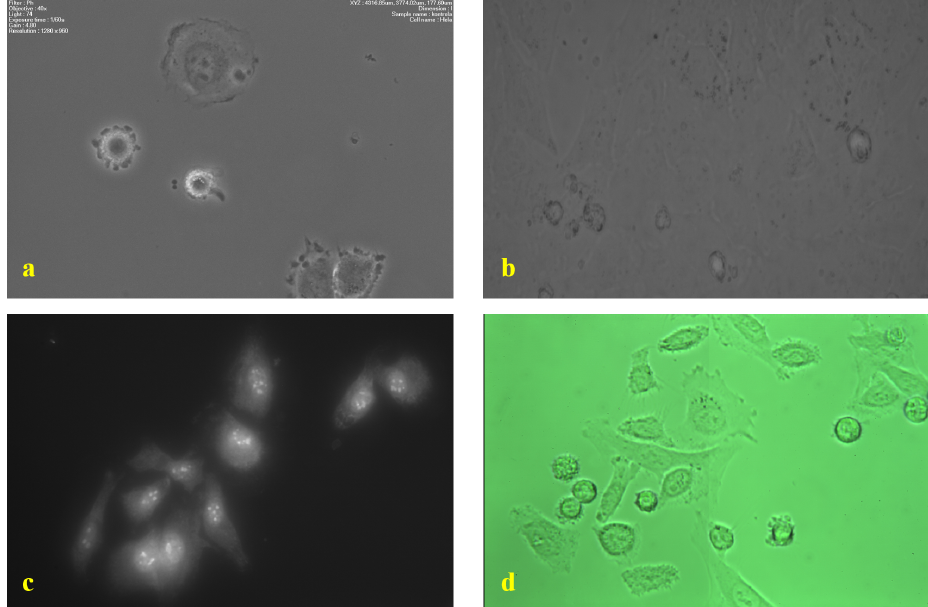
Figure 7. Eight-bit-per-channel images of HeLa cells pictured by ( a ) a phase contrast microscope Nikon BioStation IMQ (40 × objective magnification), ( b ) a bright-field microscope Olympus IX51 (40 × objective magnification), ( c ) a fluorescent microscope Nikon Eclipse 80i (40 × objective mag- nification, stained by fluorescein), and ( d ) the nanoscope (20 × objective magnification followed by 2 × projective lens magnification) giving raw image data. Panels b and d are visualized by the LIL algorithm. The descriptions of the microscope arrangements are written in Section